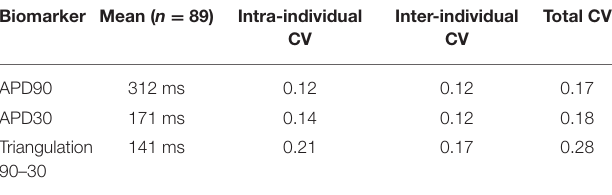
TABLE 1 | Total, intra- and inter-heart variability. Biomarker Mean ( n = 89) Intra-individual